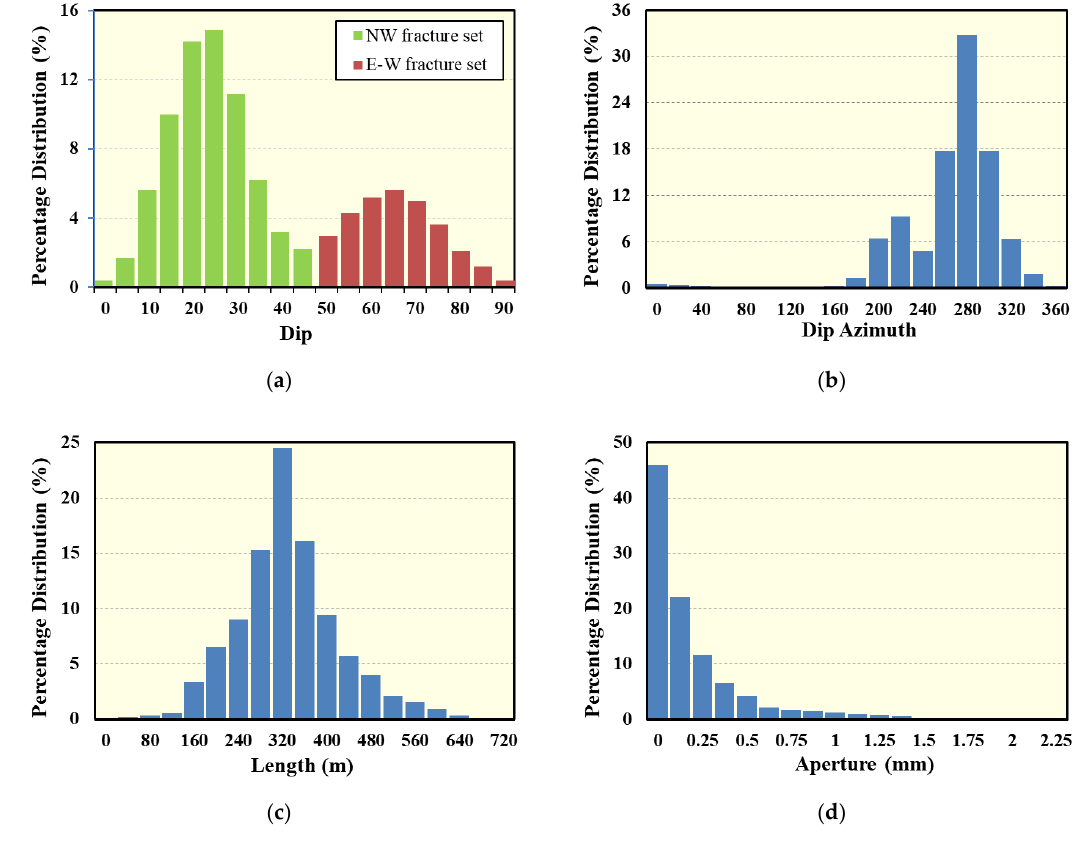
Figure 17. Histograms of Field DFN attributes: ( a ) dip angle; ( b ) azimuth; ( c ) fracture length; ( d ) fracture aperture.